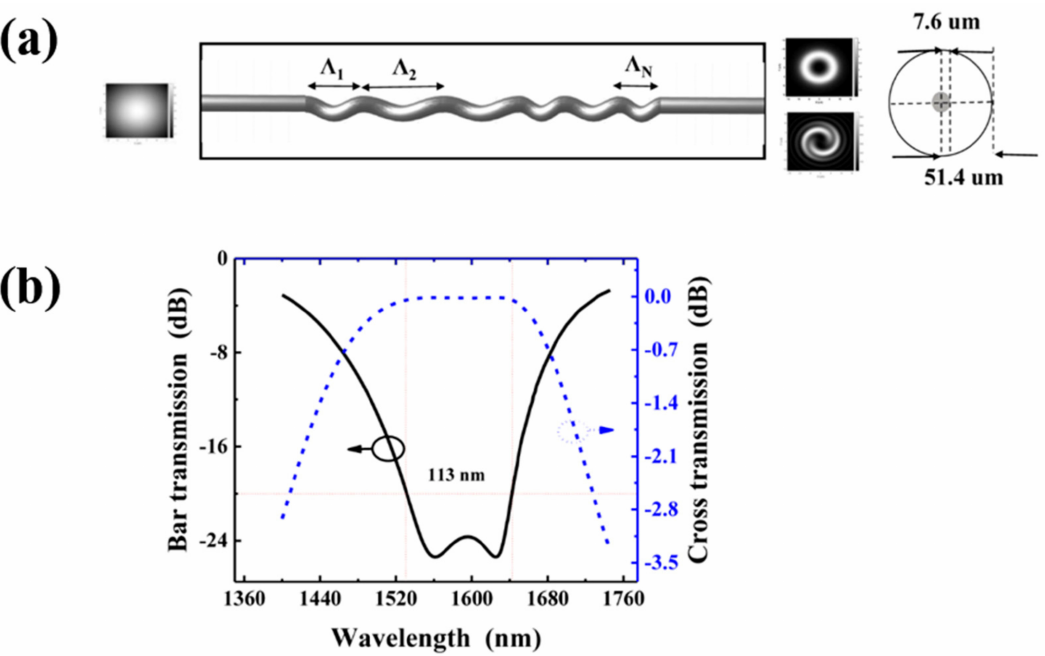
Figure 40. ( a ) The schematic diagram for the proposed phase-modulated HLPG inscribed in a thinned four-mode fiber. ( b ) Transmission spectrum of the proposed phase-modulated HLPG. Adapted with permission from ref. [184]. © The Optical